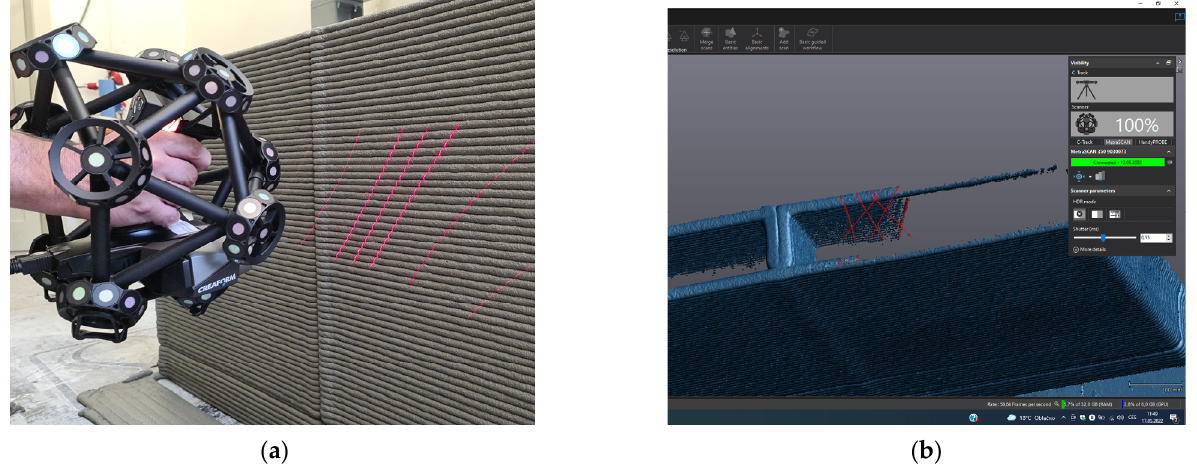
Figure 3. ( a ) Wall element scanning with MetraScan; ( b ) scanning preview in SW VX Elements.